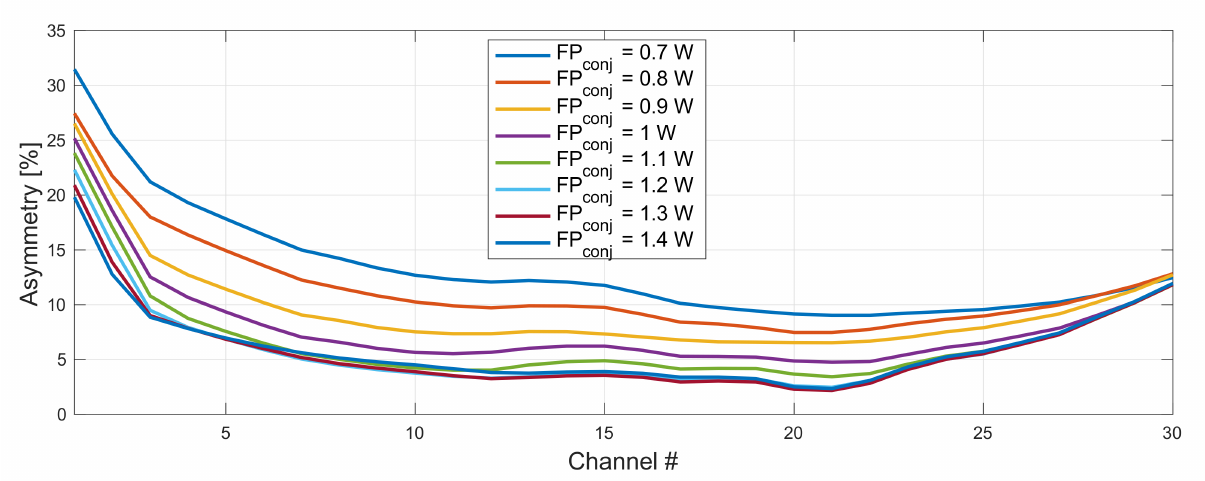
Figure 10. Impact of pump power choice (conjugated WDM grid) on asymmetry performance. Forward pump power of the original grid was fixed to be 1.1 W. FBG for original and conjugated WDM grid was set to 1460 and 1450 nm, respectively.